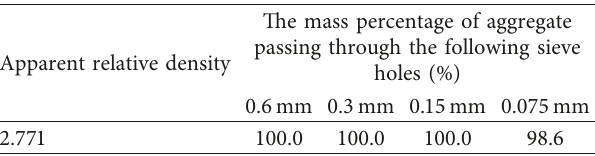
Table 6: The sieving and apparent relative density test results of